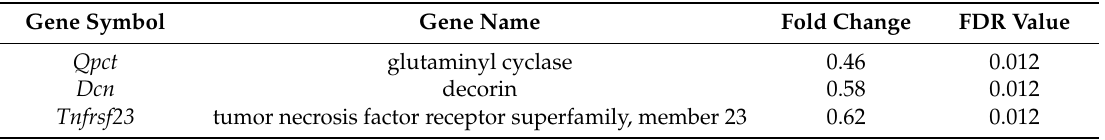
Table 2. Differentially-expressed imprinted genes in the male placentas in response to 4X versus 1X maternal choline supplementation 1